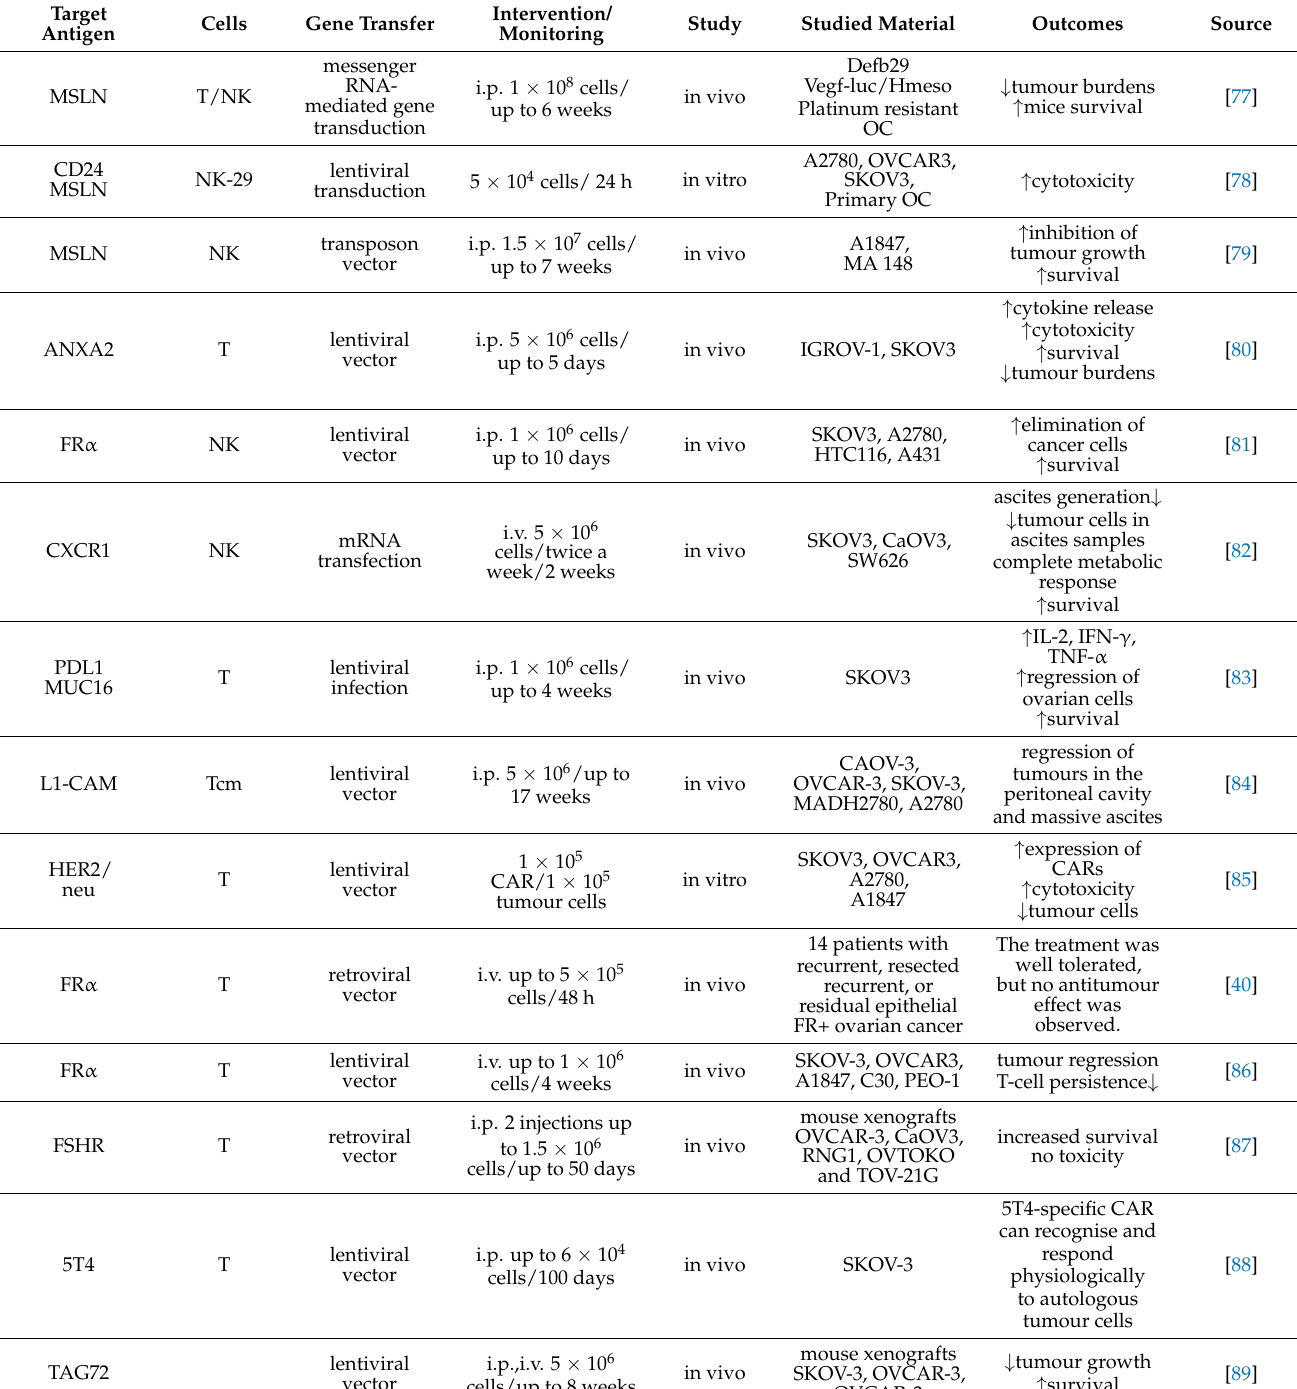
Table 2. Antigenic targets being exploited for CAR-T-cell therapy in OC treatment.